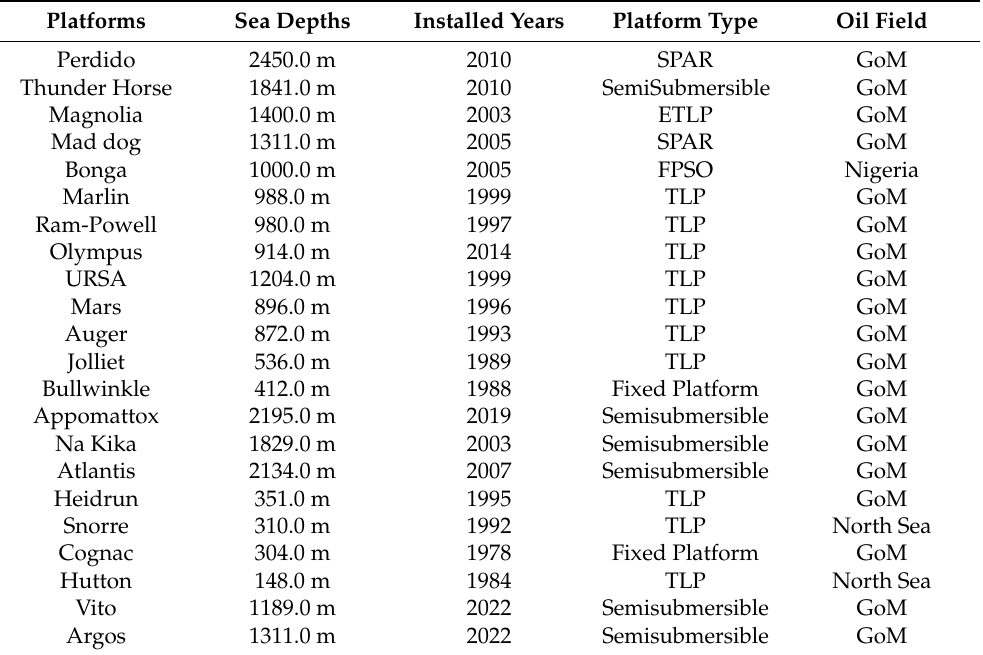
Table 1. Some deep sea facilities with installation